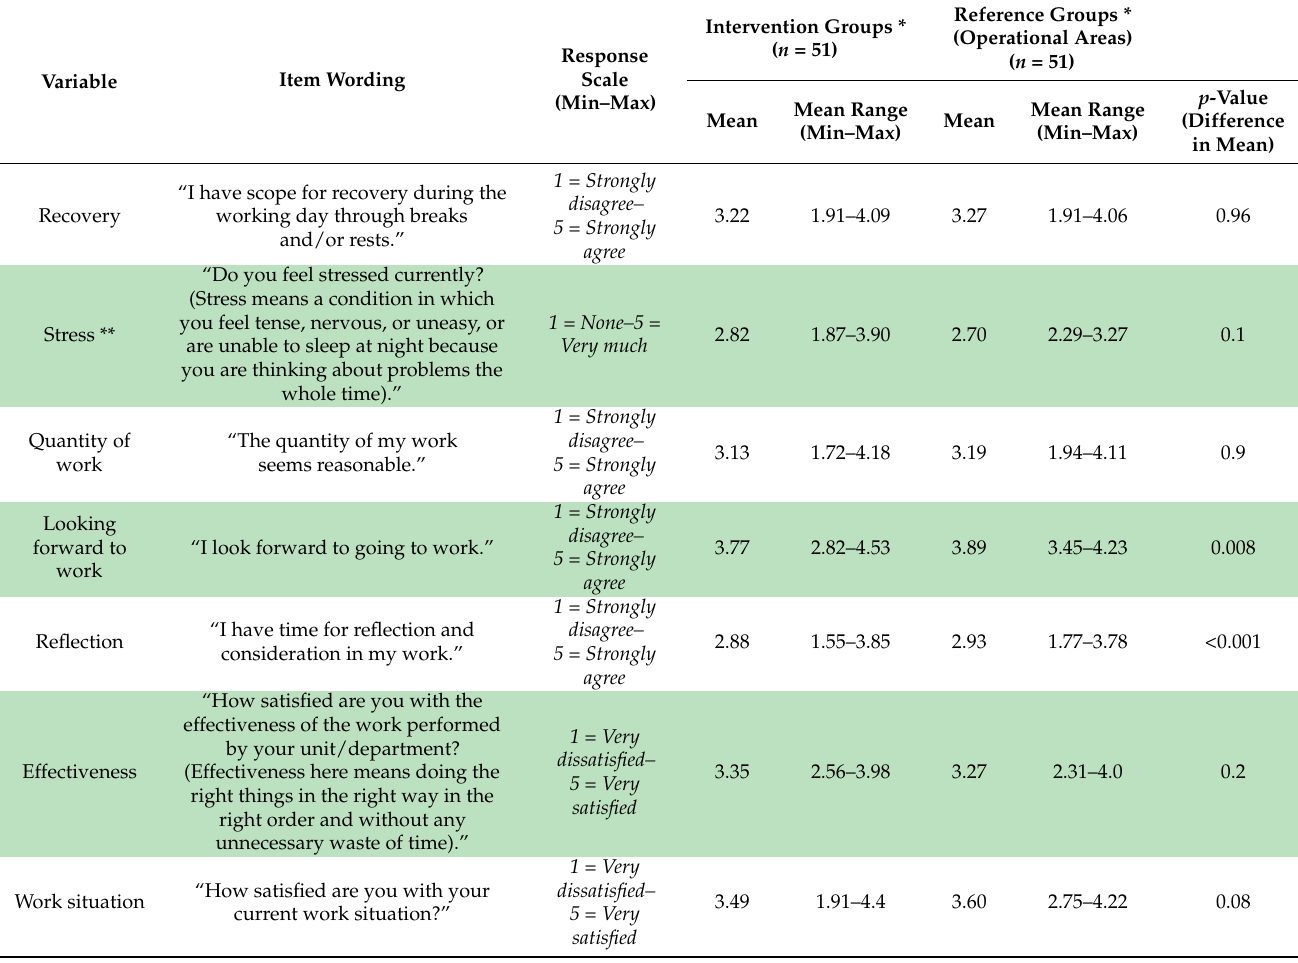
Table 2. Mean group scores for evaluated items in the employee survey (carried out in September 2017) prior to the intervention for the intervention and reference groups, and p -values for the differences between these